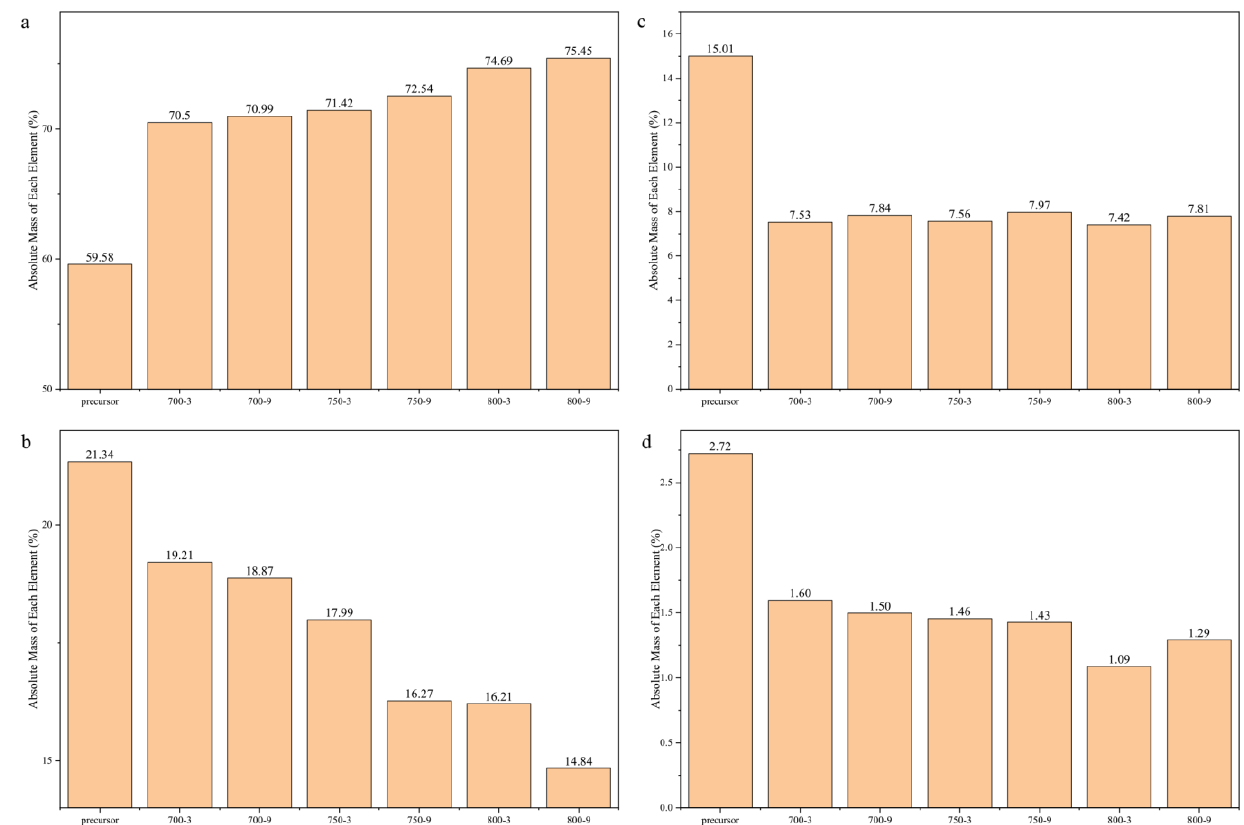
Figure 4. Element changes of the different carbon fibers: ( a ) C; ( b ) N; ( c ) O; ( d ) H.